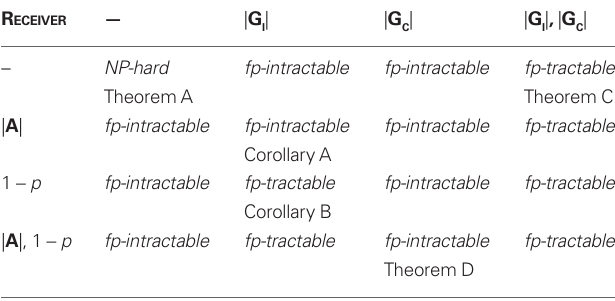
Figure A3 | [Same as Figure 2 in main text] The BiP-Bayesian network with T time slices: S where t ∈ [1, T ], is a state variable at time t ; A t where t ∈ [1, T − 1], is an action variable at time t . The goal variables, G are fixed over the different time slices. Arrows indicate probabilistic … , G K dependencies between variables in the network. Note that no direct dependencies exist between states and goals, but that any indirect dependencies between states and goals are mediated by action variables. Table A1 | Complexity results for r eceiver .